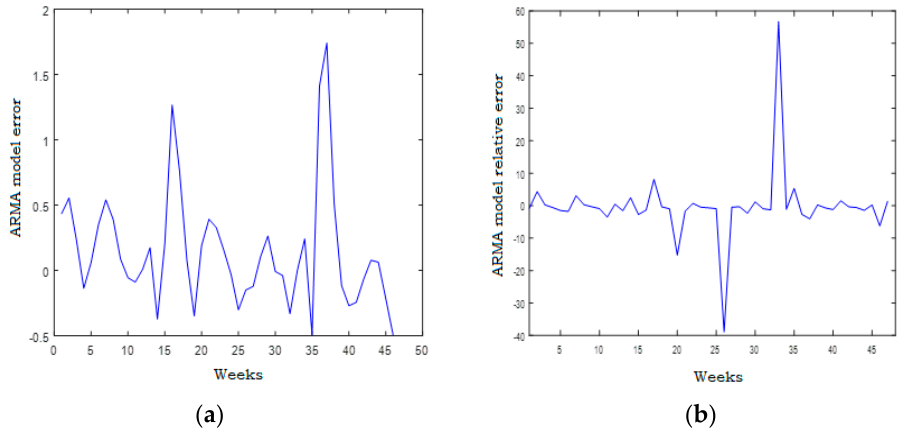
Figure 23. ( a ) Error and ( b ) relative error of the prediction of annual solar radiation using ARMA (2,1).